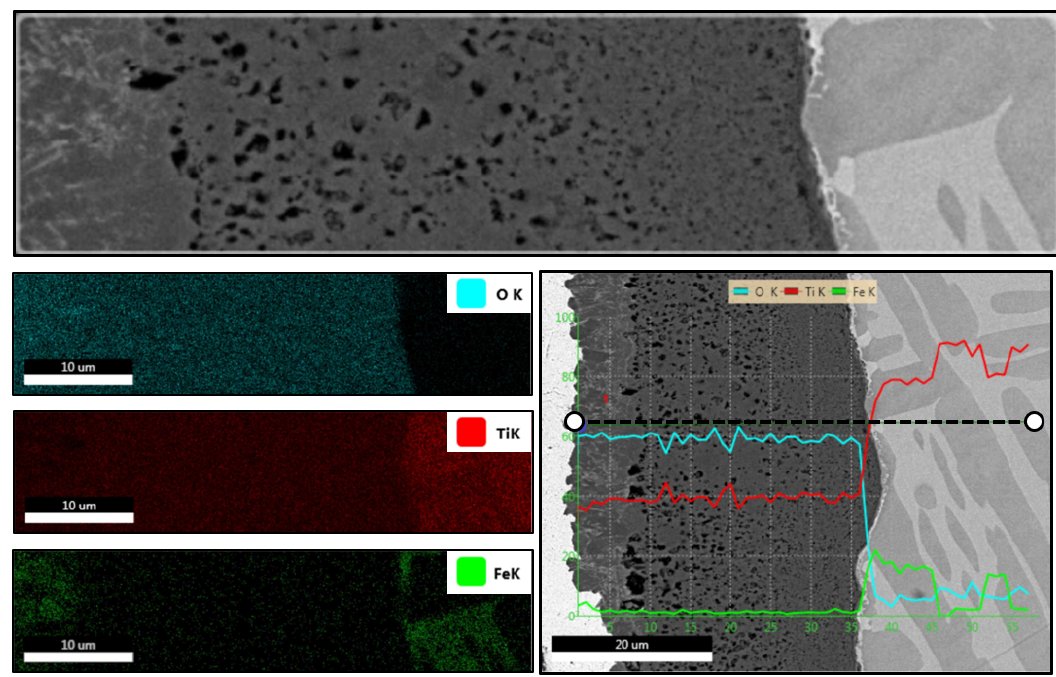
Figure 9. Results of the EDS area and linear mapping (at %) conducted on Ti-7Fe samples oxidized for 300 h at 600 °C.